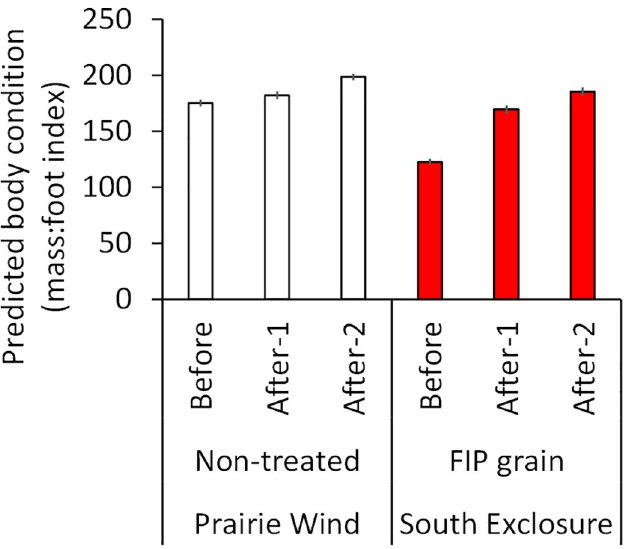
Fig 2. Predicted body condition indices (mass:foot) for black-tailed prairie dogs at Prairie Wind and South Exclosure colonies, South Dakota, USA, 2018. Two sites at the South Exclosure were treated with 0.005% fipronil (FIP) grain on 23 July. Data were collected during 3 BACI (before-after-control-impact) periods: Before FIP grain treatments (June-22 July), After-1 (25 July-30 August), and After-2 (1 September-October). Here, prairie dog ages/ sexes are combined for simplicity. Error bars are ± 1 SE